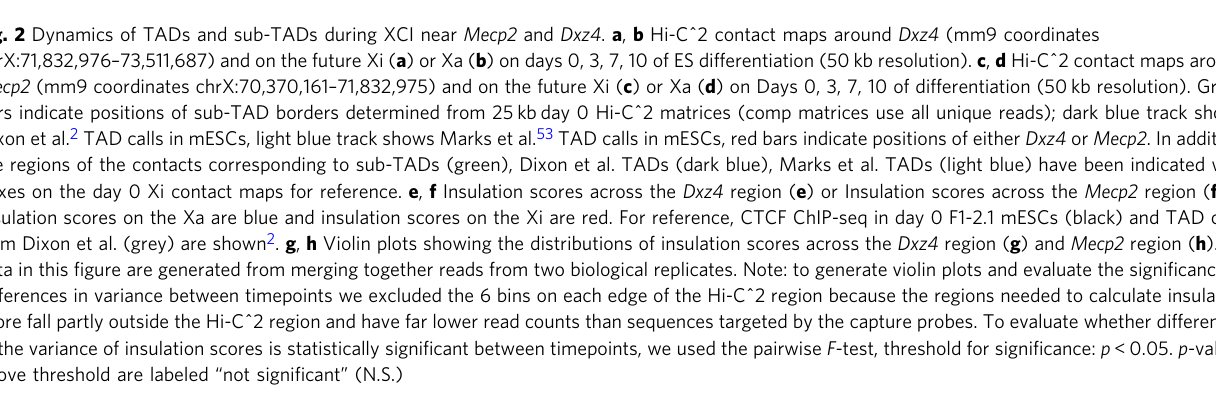
Fig. 2 Dynamics of TADs and sub-TADs during XCI near Mecp2 and Dxz4 . a , b Hi-C^2 contact maps around Dxz4 (mm9 coordinates chrX:71,832,976 – 73,511,687) and on the future Xi ( a ) or Xa ( b ) on days 0, 3, 7, 10 of ES differentiation (50 kb resolution). c , d Hi-C^2 contact maps around Mecp2 (mm9 coordinates chrX:70,370,161 – 71,832,975) and on the future Xi ( c ) or Xa ( d ) on Days 0, 3, 7, 10 of differentiation (50 kb resolution). Green bars indicate positions of sub-TAD borders determined from 25 kb day 0 Hi-C^2 matrices (comp matrices use all unique reads); dark blue track shows Dixon et al. 2 TAD calls in mESCs, light blue track shows Marks et al. 53 TAD calls in mESCs, red bars indicate positions of either Dxz4 or Mecp2 . In addition, the regions of the contacts corresponding to sub-TADs (green), Dixon et al. TADs (dark blue), Marks et al. TADs (light blue) have been indicated with boxes on the day 0 Xi contact maps for reference. e , f Insulation scores across the Dxz4 region ( e ) or Insulation scores across the Mecp2 region ( f ). Insulation scores on the Xa are blue and insulation scores on the Xi are red. For reference, CTCF ChIP-seq in day 0 F1-2.1 mESCs (black) and TAD calls from Dixon et al. (grey) are shown 2 . g , h Violin plots showing the distributions of insulation scores across the Dxz4 region ( g ) and Mecp2 region ( h ). All data in this fi gure are generated from merging together reads from two biological replicates. Note: to generate violin plots and evaluate the signi fi cance of differences in variance between timepoints we excluded the 6 bins on each edge of the Hi-C^2 region because the regions needed to calculate insulation score fall partly outside the Hi-C^2 region and have far lower read counts than sequences targeted by the capture probes. To evaluate whether differences in the variance of insulation scores is statistically signi fi cant between timepoints, we used the pairwise F -test, threshold for signi fi cance: p < 0.05. p -values above threshold are labeled “ not signi fi cant ”